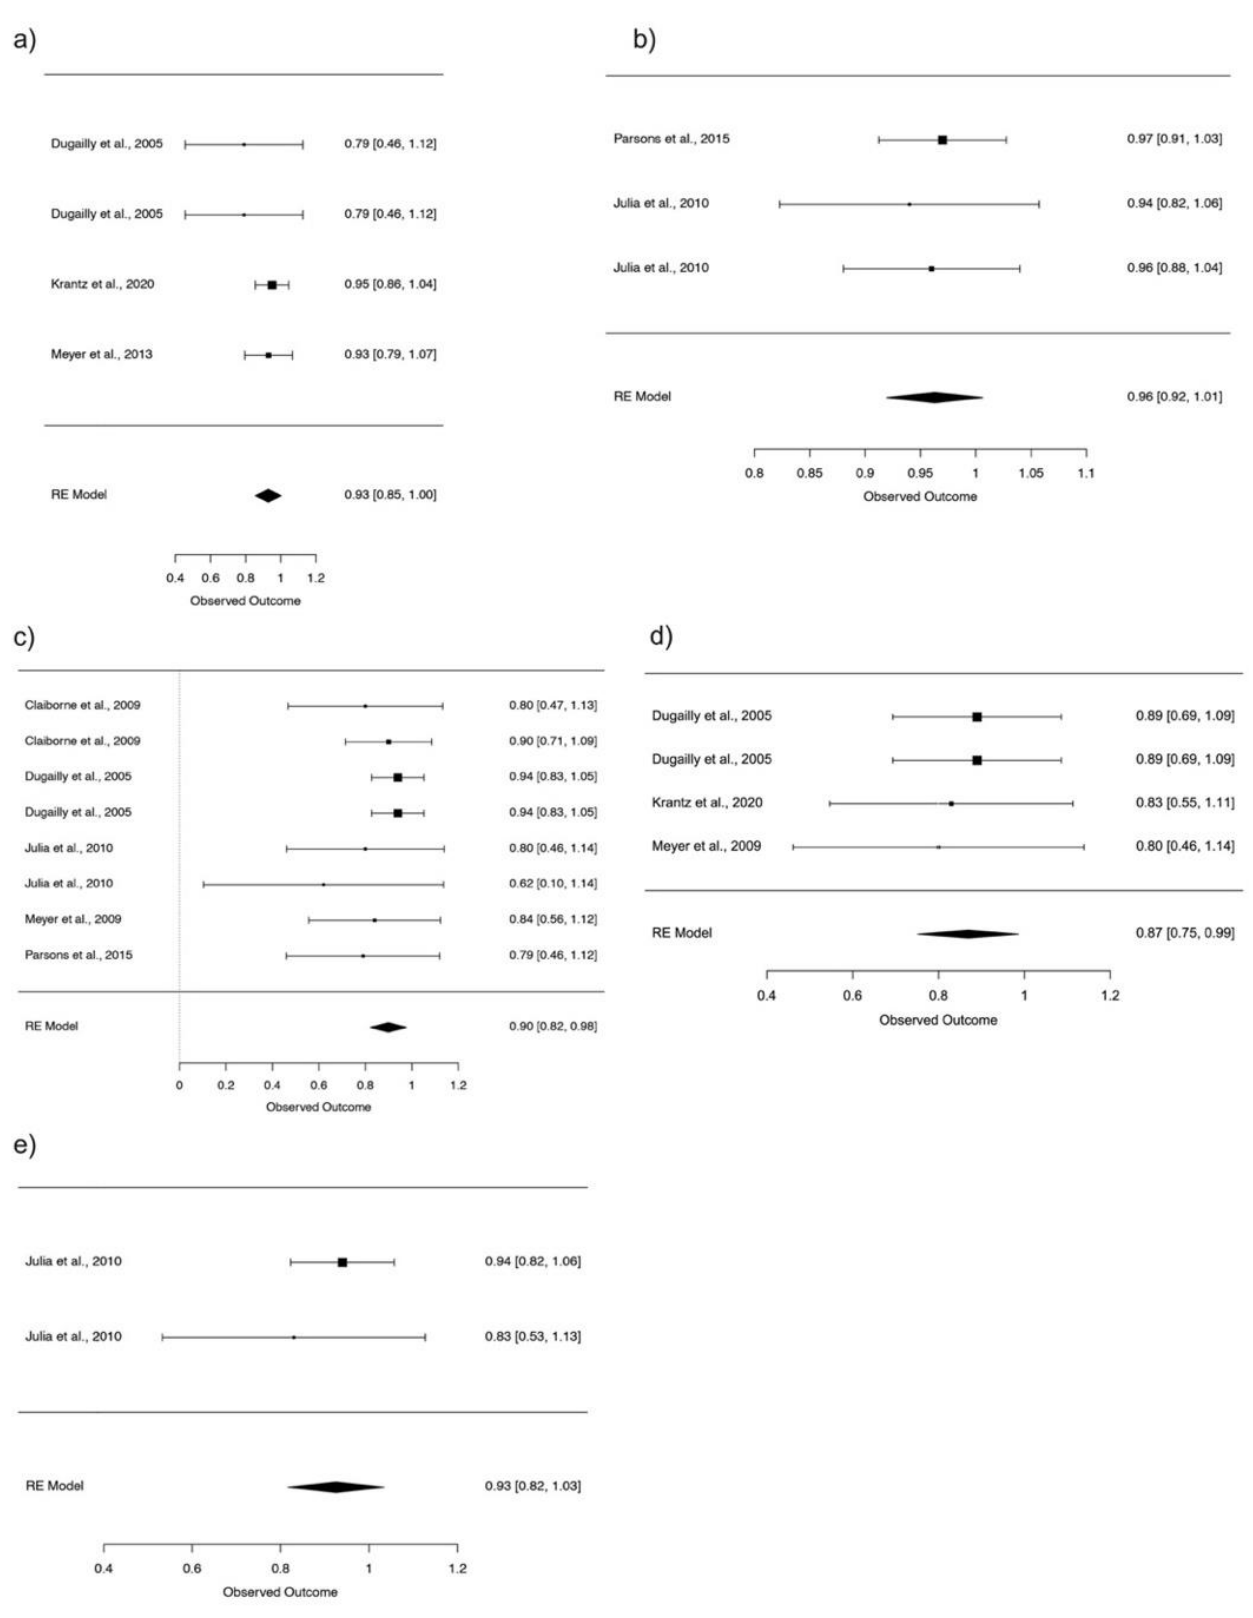
Figure 4. Forest plot, 95% confidence interval (CI95%) for reliability hip flexion 120°/s ( a ), reliability hip flexion 180°/s ( b ), reliability hip extension 60°/s ( c ) reliability hip extension 120°/s ( d ) and reliability hip extension 180°/s ( e ).